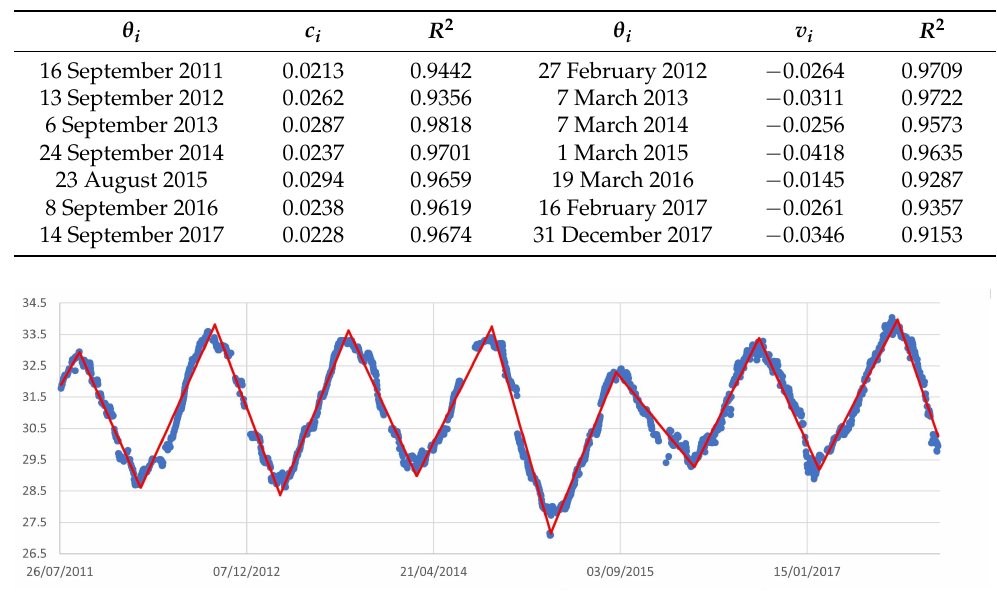
Figure 3. The scatter plot of the data series X ( t ) and the linear approximation of the deterministic trend r ( t ) .